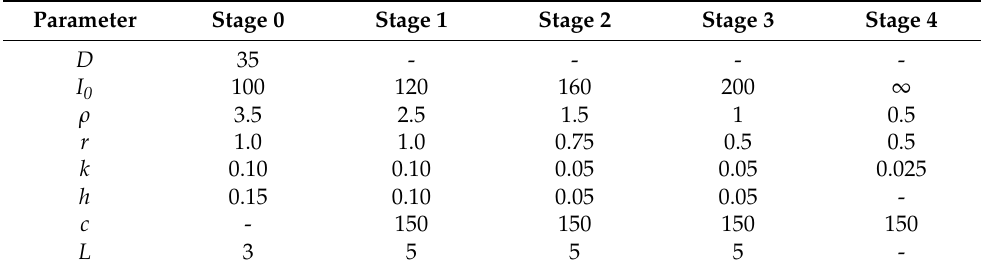
Table 2. Parameter values for the second numerical experiment. The first column contains model parameters. Stages from 0 to 4 correspond to different supply chain participants, from retail (stage 0) to a source of raw materials (stage 4).